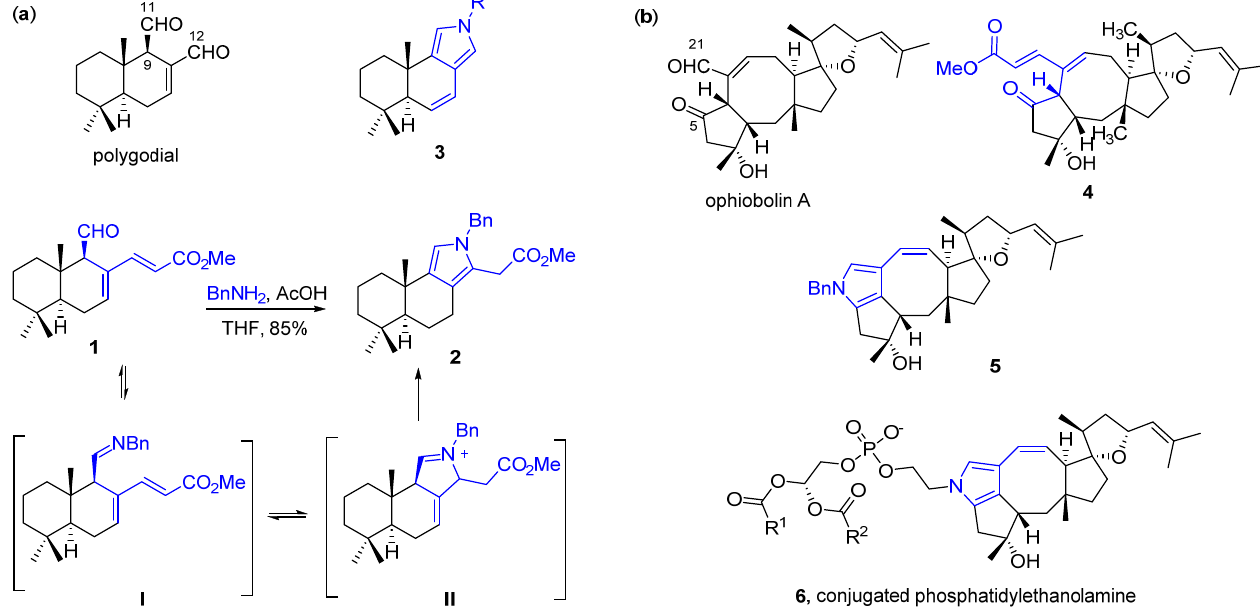
Figure 1. ( a ) Structures of polygodial, Wittig product 1 , a proposed mechanism for pyrrole 2 formation involving intermediates I and II, unstable pyrrole 3 ; ( b ) Structures of ophiobolin A, Wittig product 4, pyrrole 5 and conjugated phosphatidylethanolamine 6